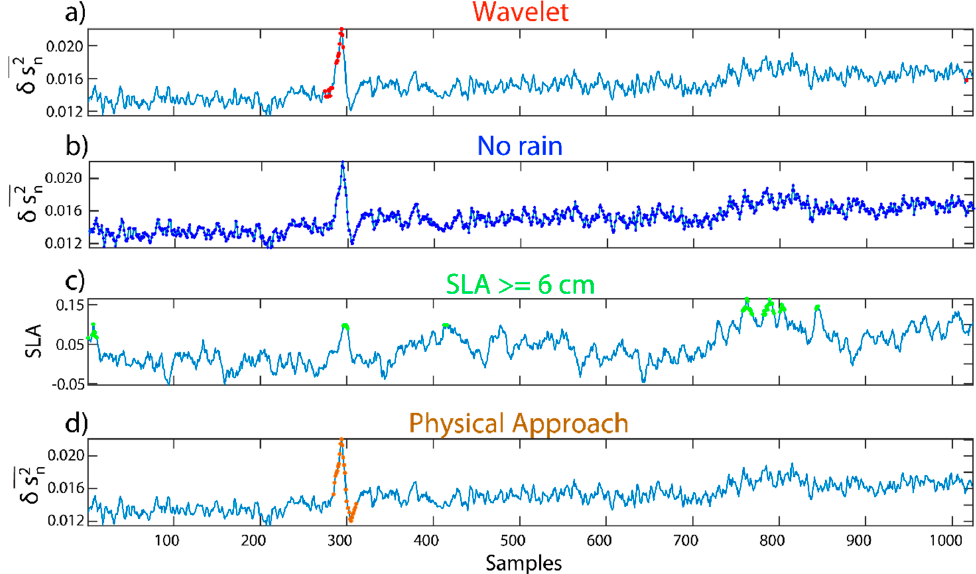
Figure 5. Along-track δ s 2 n measurements for relative orbit 152, cycle 036 over the tropical Atlantic at latitudes approximately between 5.6 ◦ N and 2.6 ◦ N (as in Figure 4). ( a ) The red colors represent the positions where the wavelet analysis detects ISWs. ( b ) The same record, but where the blue colors show the positions una ff ected by anomalous liquid water or water vapor content (see text for details). ( c ) The green colors indicate where the sea level anomaly (SLA) exceeds 6 cm in ISW scales. ( d ) The result of the “physical approach” is shown, i.e., the brown colors represent the positions where the δ s 2 n parameter are outside the one rms of the altimeter wind speed measurements.